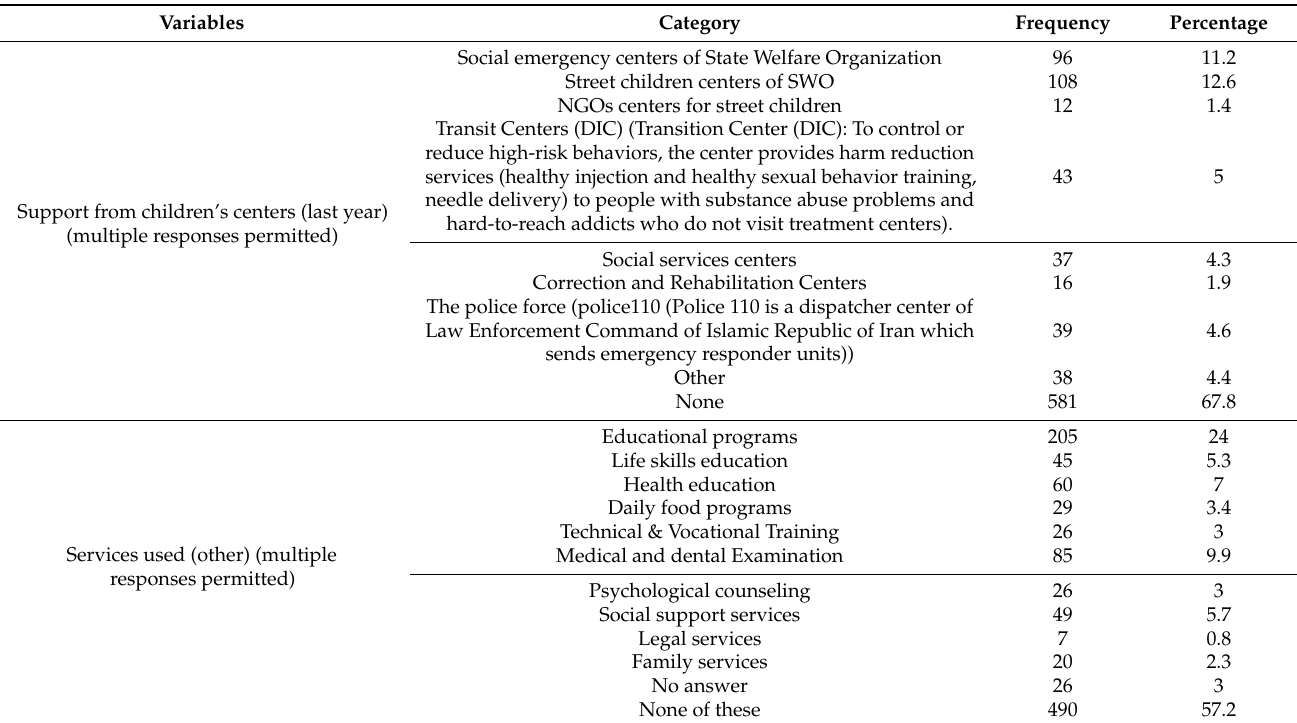
Table 4. Child centers and intervention programs relevant for street children in six provinces of Iran ( n =